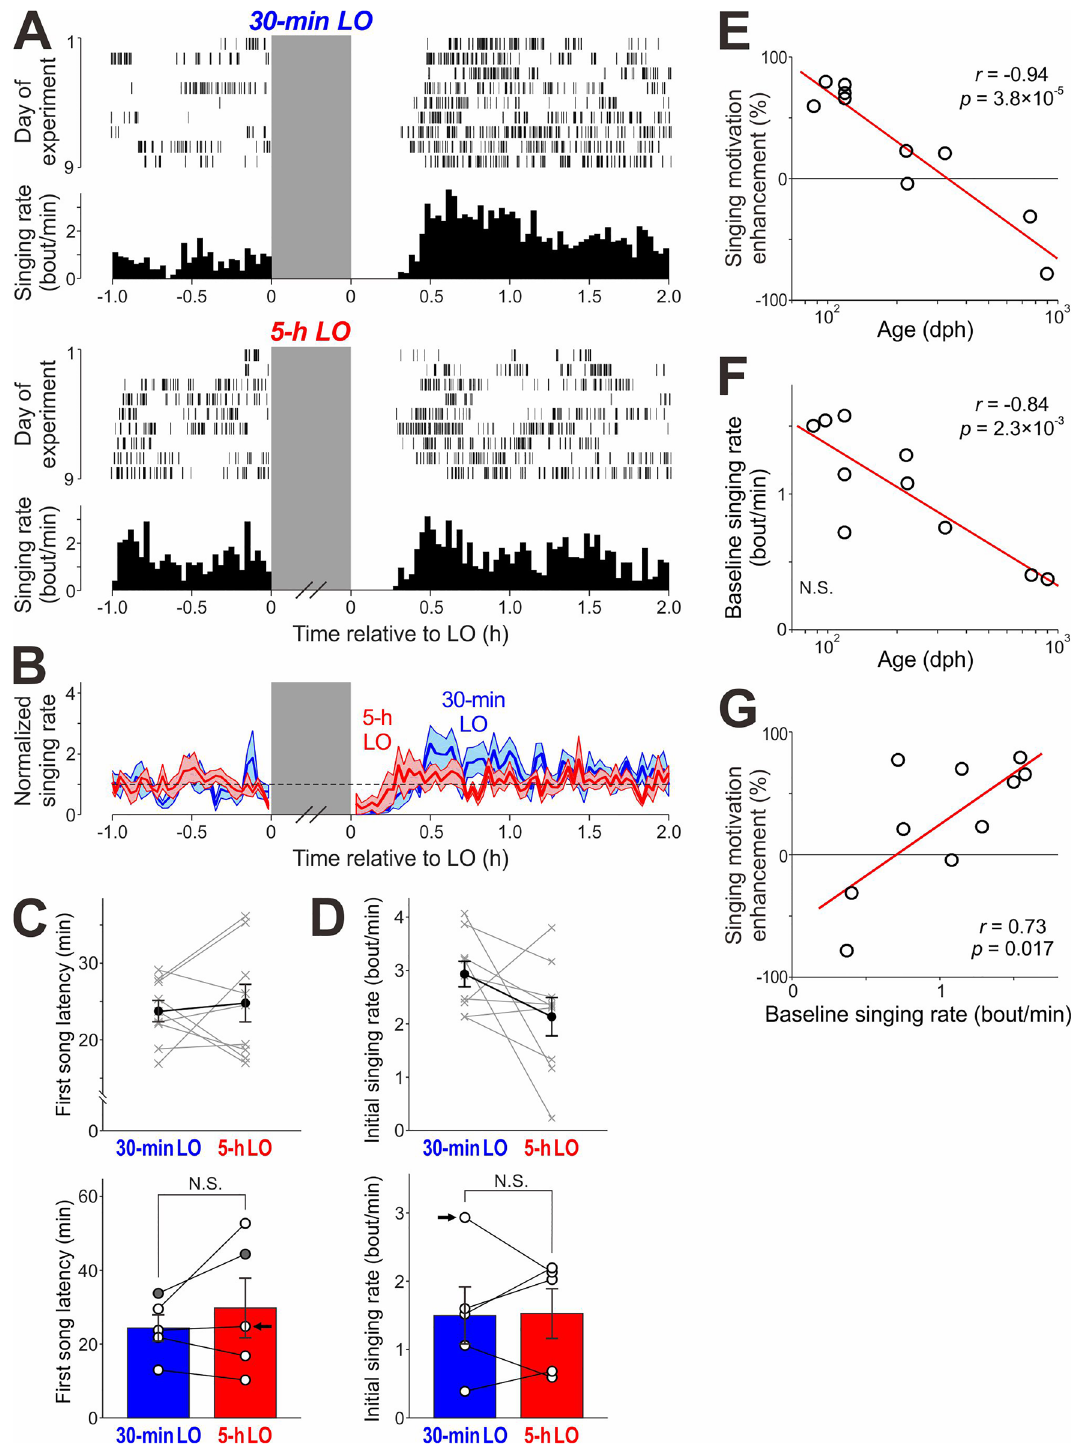
Figure 4. Singing suppression-induced enhancement of singing motivation depends on age. ( A ) Raster plot of song bouts produced before and after 30-min LO (top) and 5-h LO (bottom) and corresponding singing rate histograms in a relatively old adult bird (222 dph on the first day of the experiment). ( B ) Time course of instantaneous singing rate before and after 30-min (blue) and 5-h LO (red), normalized to the mean singing rate before LO (mean ± SEM, n = 5 birds). ( C ) The first song latencies after 5-h LO and those after 30-min LO in the bird shown in ( A ) ( top ) and in all the birds examined (n = 5 birds, bottom ). Conventions are same as in Fig. 1E. As a group, first song latencies were not significantly different between 5-h LO and 30-min LO ( p = 0.63). ( D ) Initial singing rates after 5-h LO and those after 30-min LO in the bird shown in ( A ) ( top ) and in all the birds examined (n = 5 birds, bottom ). There was no significant difference between 5-h LO and 30-min LO ( p = 1). ( E ) Magnitude of singing motivation enhancement (see “Methods”) plotted against birds’ age (n = 10 birds including both young and old adults). The red line indicates linear regression. ( F ) Baseline singing rates plotted against birds’ age. ( G ) Magnitude of singing motivation enhancement plotted against baseline singing